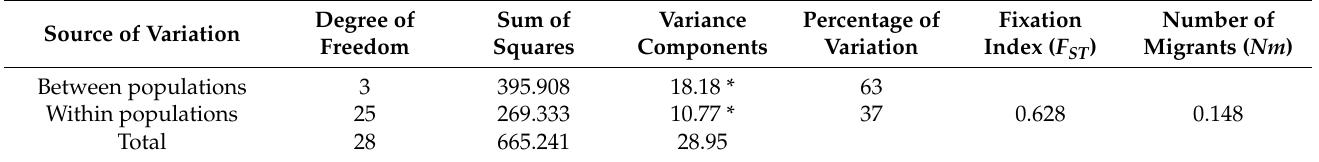
Table 7. Analysis of the molecular variance (AMOVA) of Meloidogyne javanica populations based on RAPD and ISSR